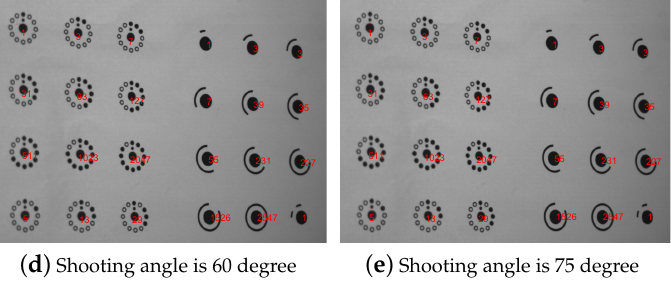
Figure 5. Comparing the influence of shooting angle on the